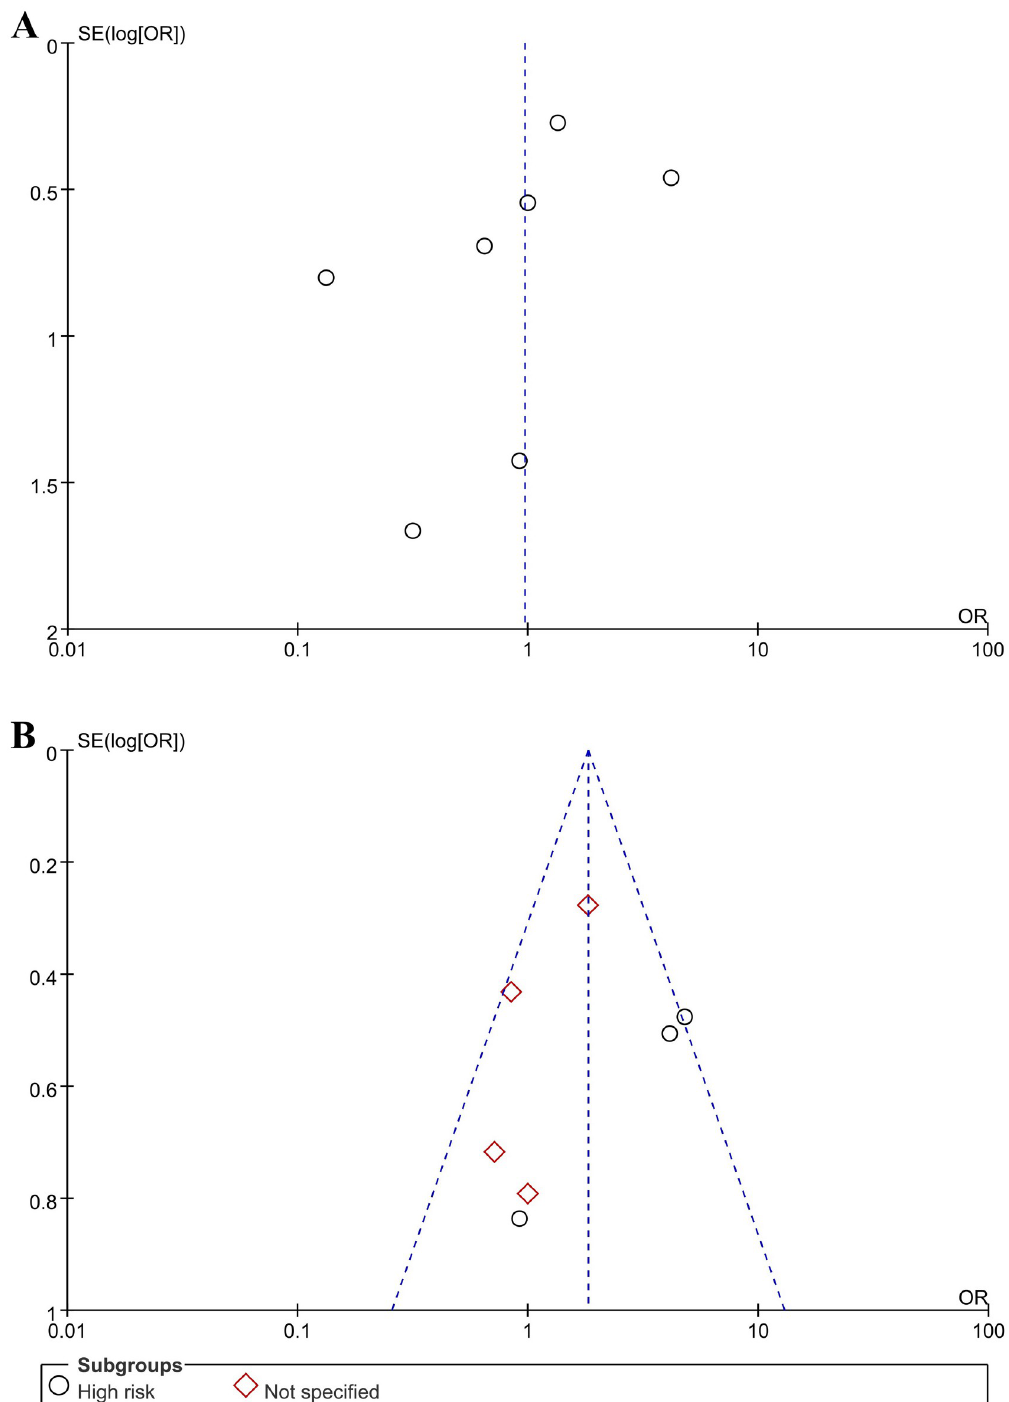
Fig 2. Funnel plot. (A) Single dose vs. extended dose in patients with fever; (B) Single dose vs. extended dose in patients with SIRS.